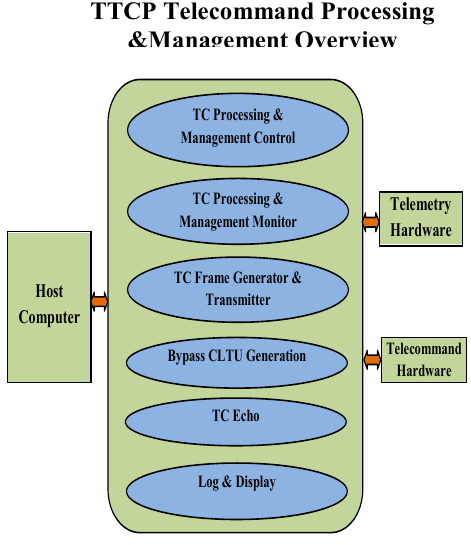
Figure 3. Functional blocks of TTCP Telecommand